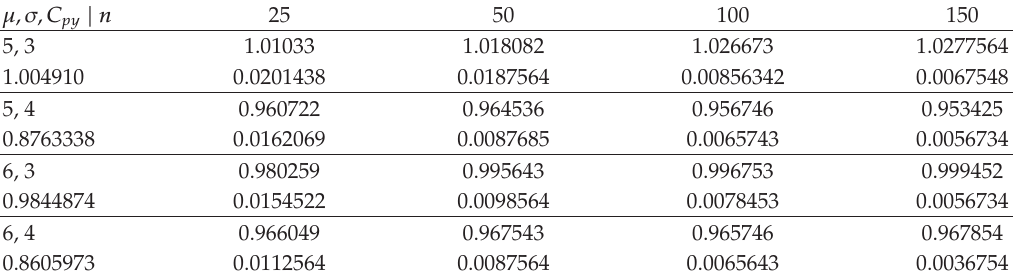
Table 1: Bayes Estimates of C